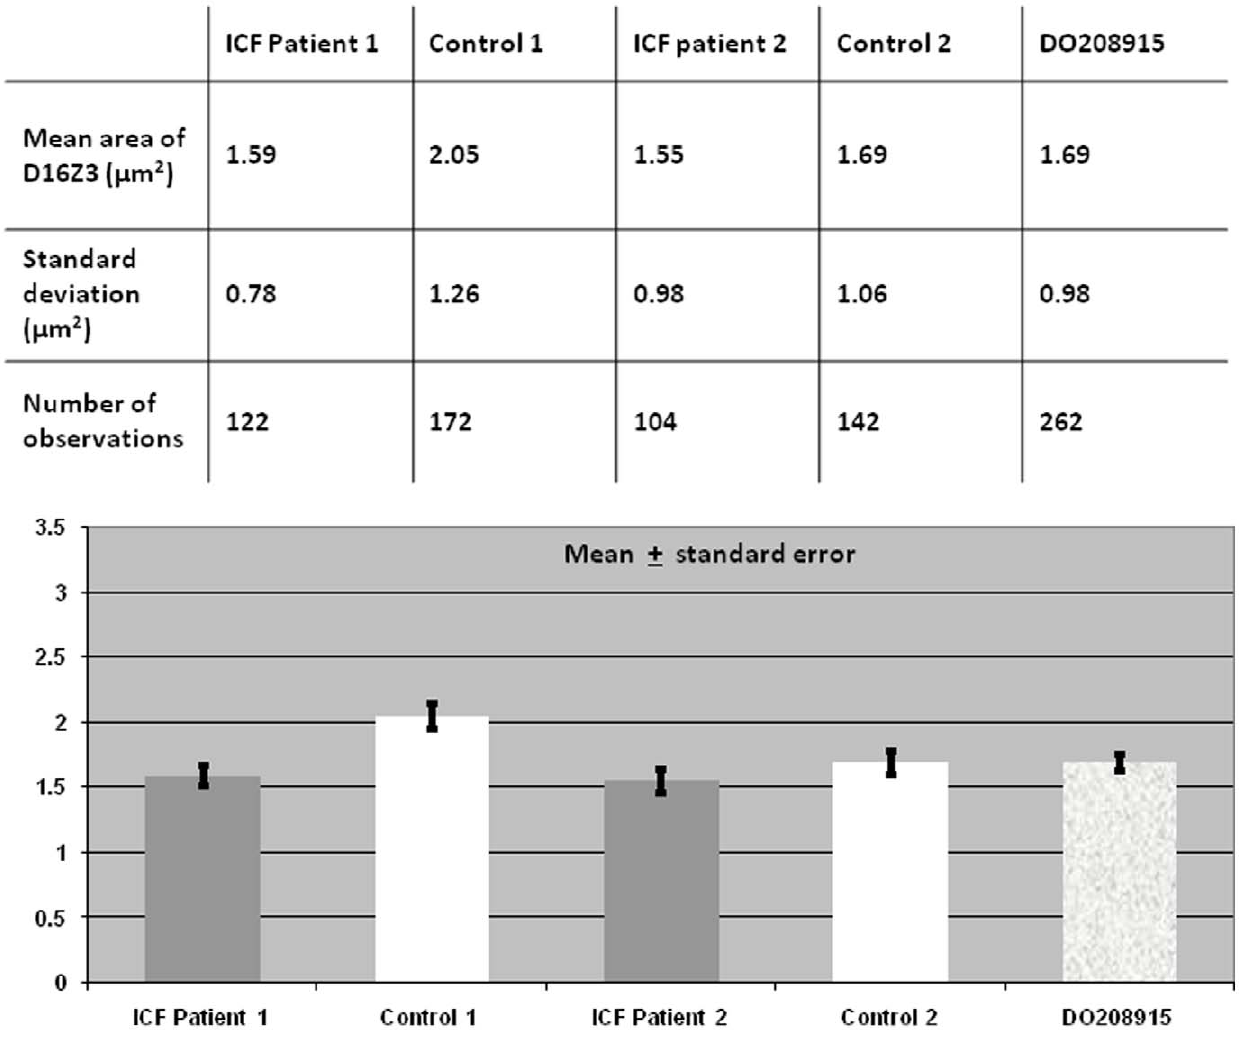
Figure 3. Chromosome 16 juxtacentromeric heterochromatin: area measurements in ICF cells and controls. Measurements of the areas occupied by chromosome 16 juxtacentromeric heterochromatin, as defined by hybridisation with the D16Z3 classical satellite DNA probe, were obtained in hundreds of 2D-fixed interphase nuclei per cell line and the mean values calculated. The measurements were performed as described in the Materials and Methods. The data sets were compared using a Kolmogorov-Smirnov test and no statistically significant difference was observed between ICF patients and Controls altogether (D=0.1029, P=0.076).